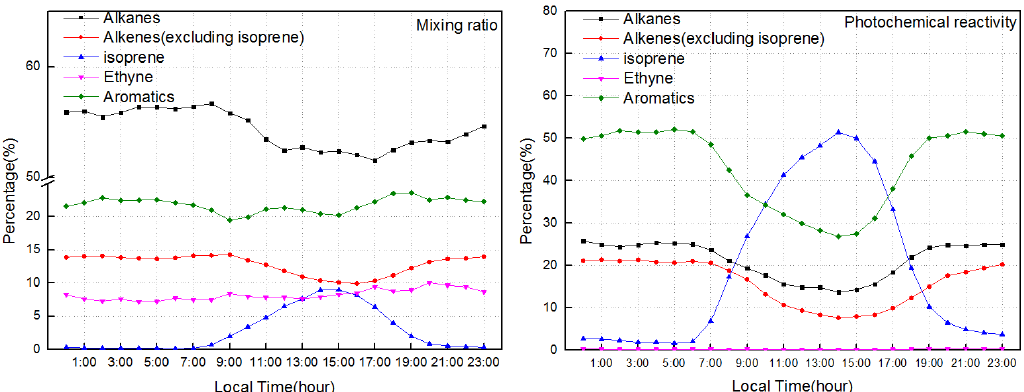
Figure 7. Diurnal variations of fractional contributions of isoprene and four categories (alkanes, alkenes (excluding isoprene), aromatics, and ethynes) to the total mixing ratio and total photochemical reactivity, respectively, from June 2011 to May 2012 at GPACS.